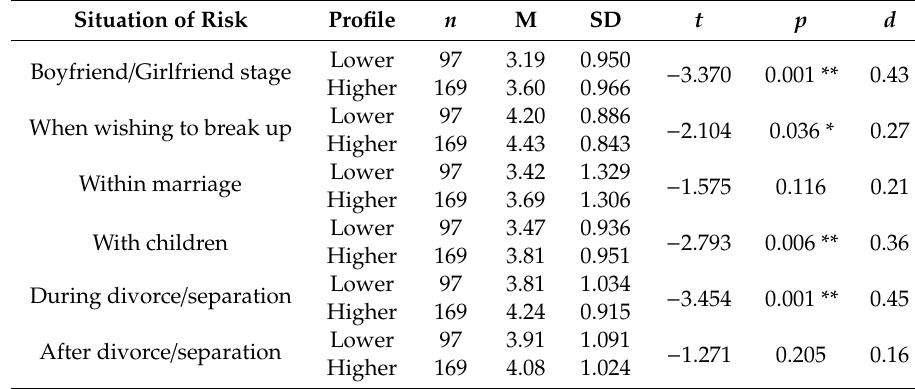
Table 4. Significant di ff erences in situation of risk in a relationship between groups with a higher and lower knowledge of situations of